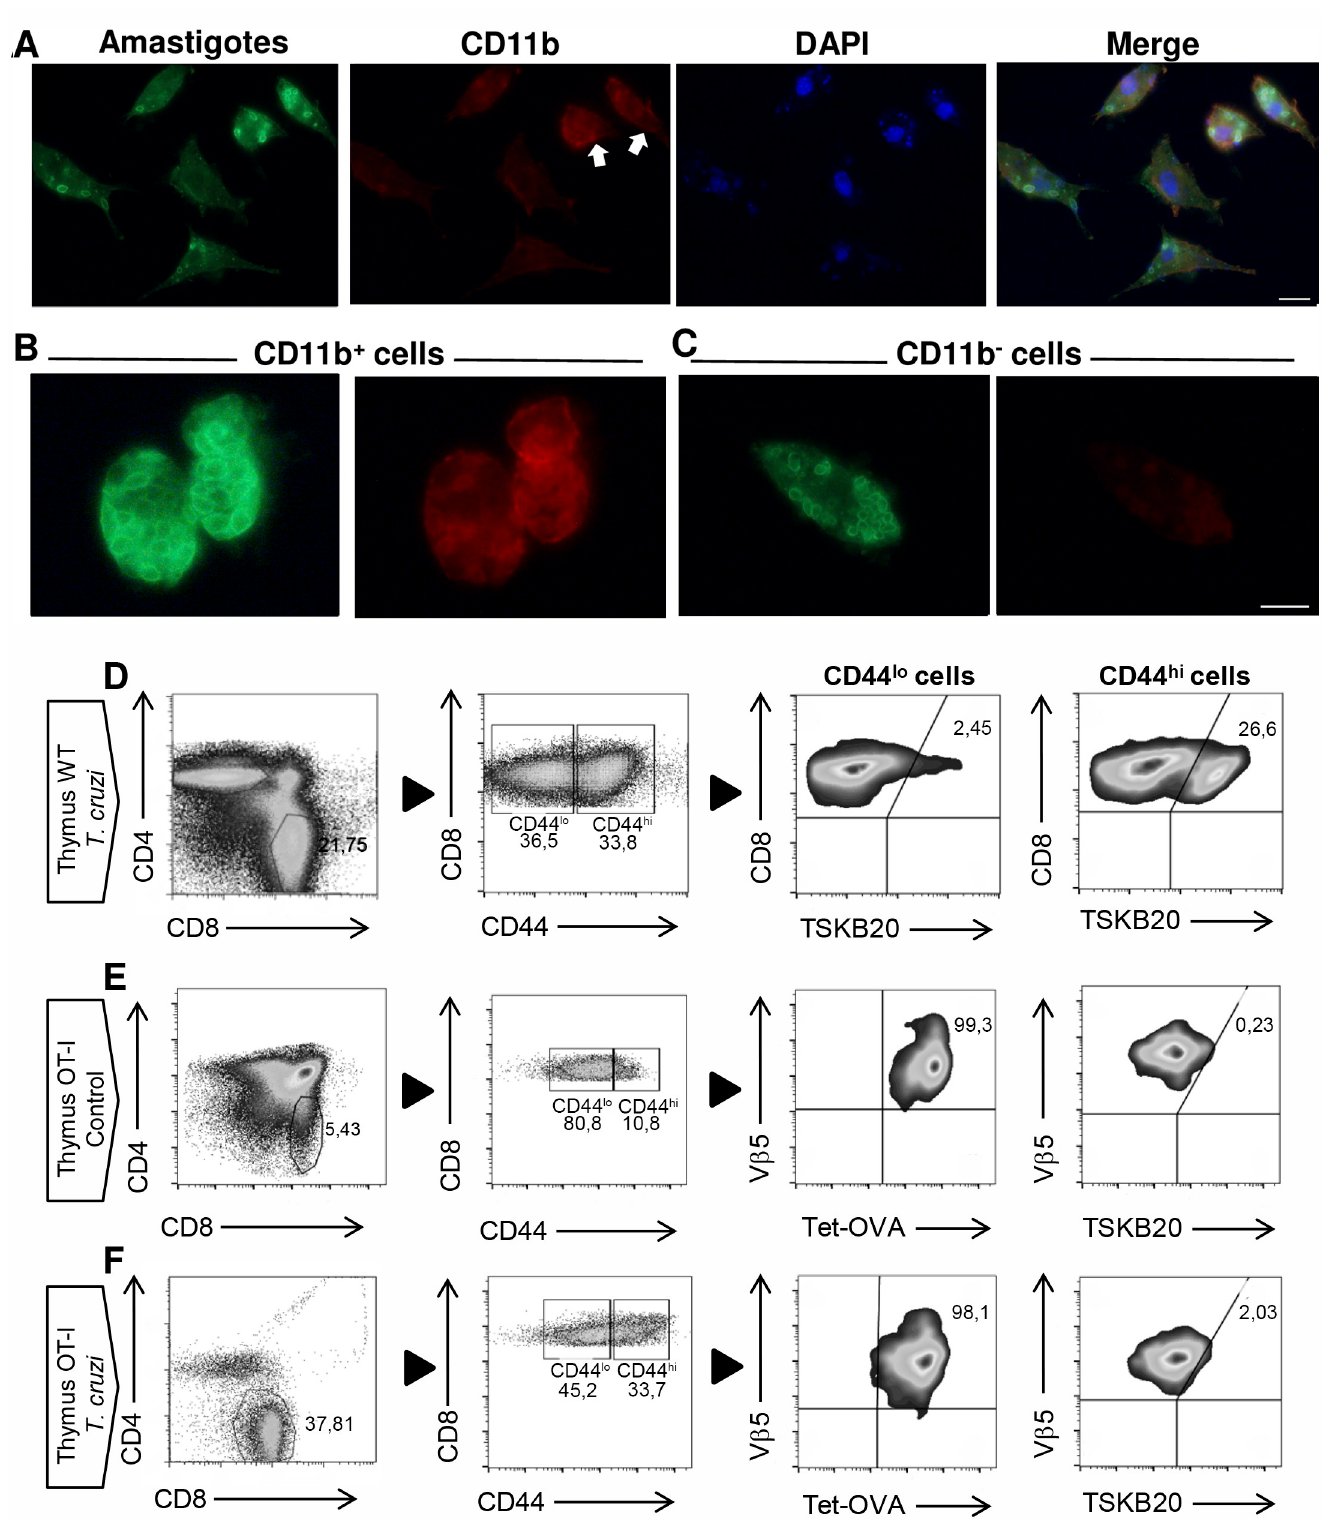
Fig 1. Ag-specific CD8 + T cells correlates with the presence of amastigotes in the thymus of T . cruzi -infected mice. WT mice were infected with T . cruzi (Tulahuen) and thymic cell suspensions were obtained 14 days post-infection. (A-C) Adherent cells were stained with an antiserum from a chagasic patient and